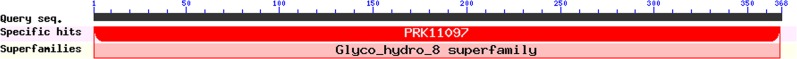
Conserved domains prediction of the EglC.Conserved domains prediction was performed by NCBI CD-search software (https://www.ncbi.nlm.nih.gov/Structure/cdd/wrpsb.cgi).